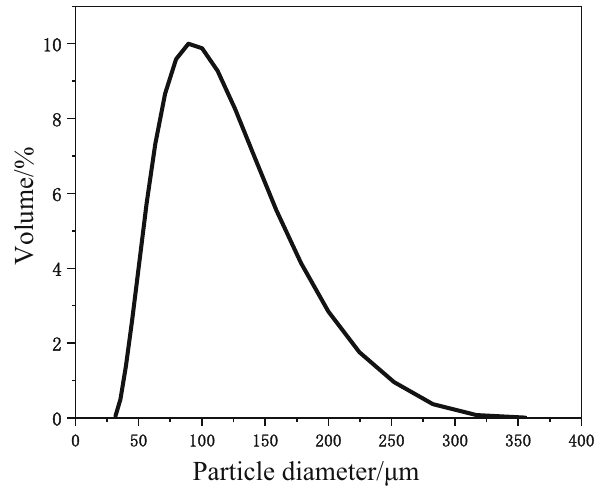
Figure 1: Particle size distribution of Co